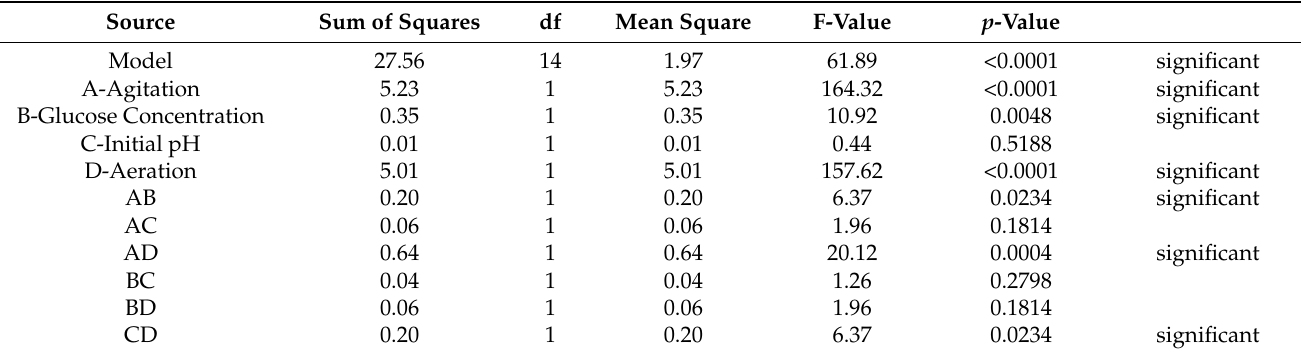
Table 4. The experimental results from the CCD quadratic model for biomass derived from G. lucidum strain QRS 5120 mycelia were subjected to an